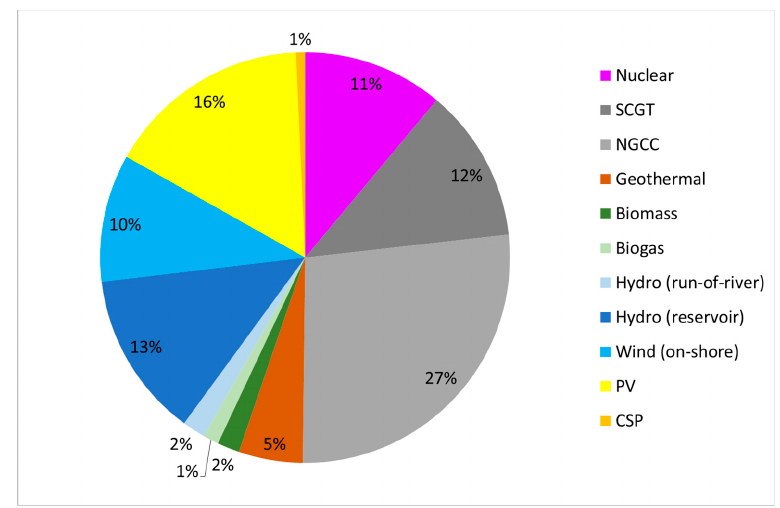
Figure 1. California domestic electricity generation mix—historical data for 2018 from CAISO. Total domestic generation was 165 TWh. SCGT = single cycle gas turbines; NGCC = natural gas combined cycles; PV = photovoltaics; CSP = concentrating solar power.